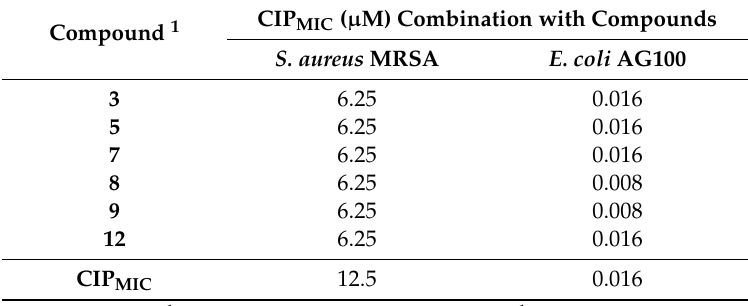
Table 2. Minimum inhibitory concentration (MIC) of ciprofloxacin (CIP) in combination with compounds in Staphylococcus aureus MRSA 272123 and E. coli